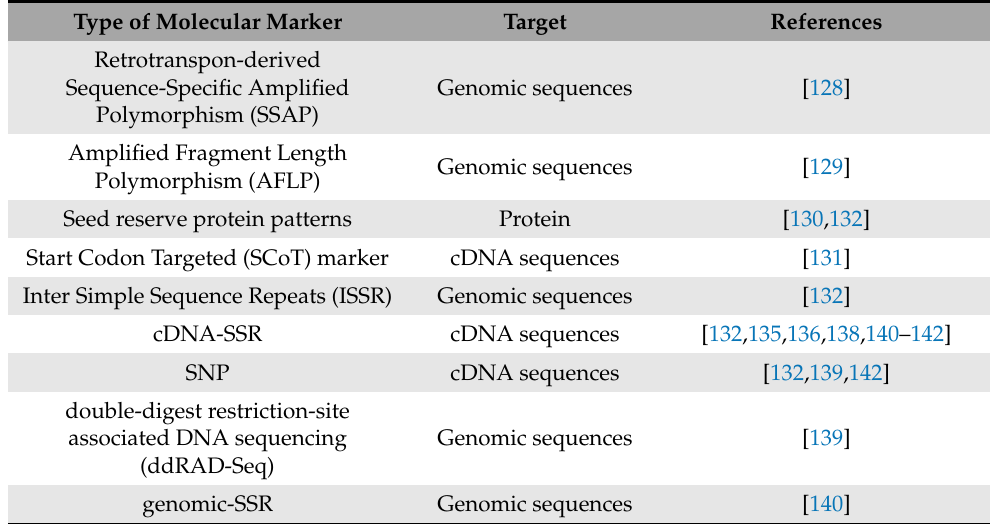
Table 2. Summary of molecular markers used for diversity characterization of V. sativa germplasm. Type of Molecular